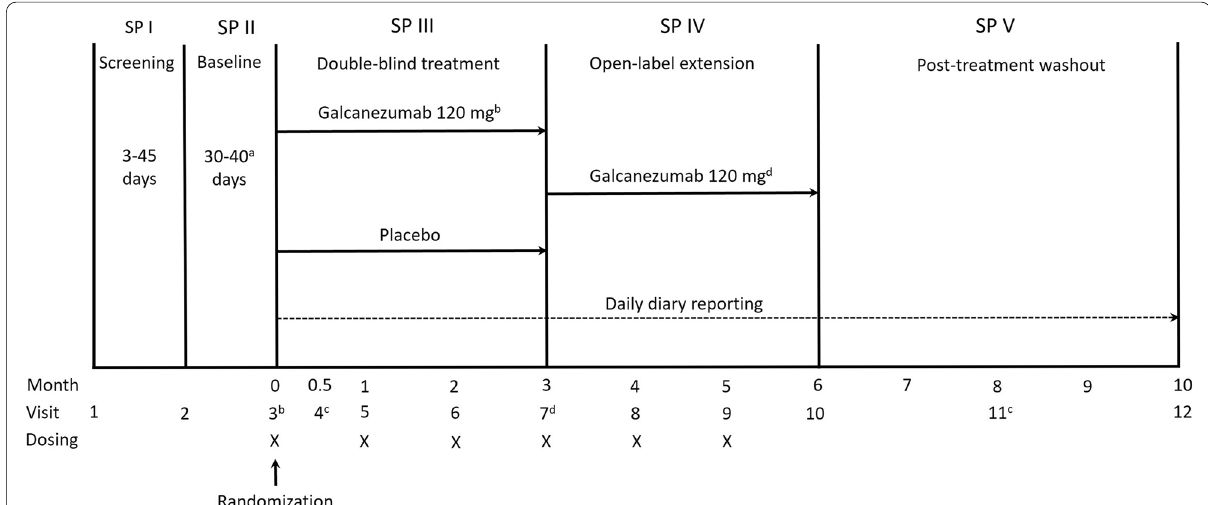
Fig. 1 Study design. a Eligibility period determined between a minimum of 30 days and a maximum of 40 days. b Patients randomized to galcanezumab 120 mg received a loading dose of 240 mg at the first injection only (Visit 3). c Telephone visits. dAt Visit 7, patients randomized to placebo who entered the open-label extension received galcanezumab at a loading dose of 240 mg, while patients randomized to galcanezumab 120 mg continued treatment at the 120 mg dose. SP, study period; X indicates when dosing